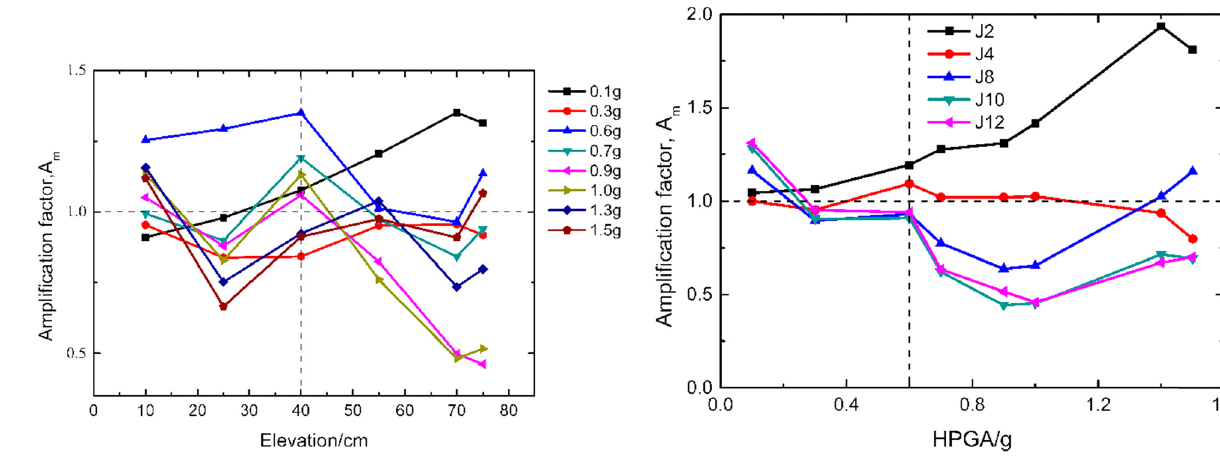
Figure 14: Ampli fi cation factor A m at JY1, JY2, JY3, and JY4 against variable HPGA.